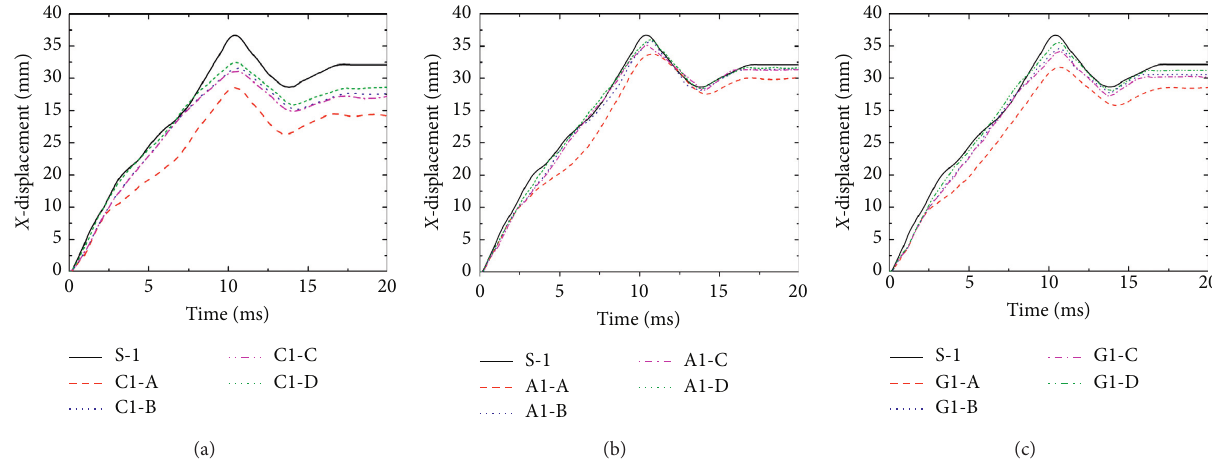
Figure 14: Displacement history curve at midspan of the columns retrofitted with different modes. (a) CFRP. (b) AFRP. (c) GFRP.